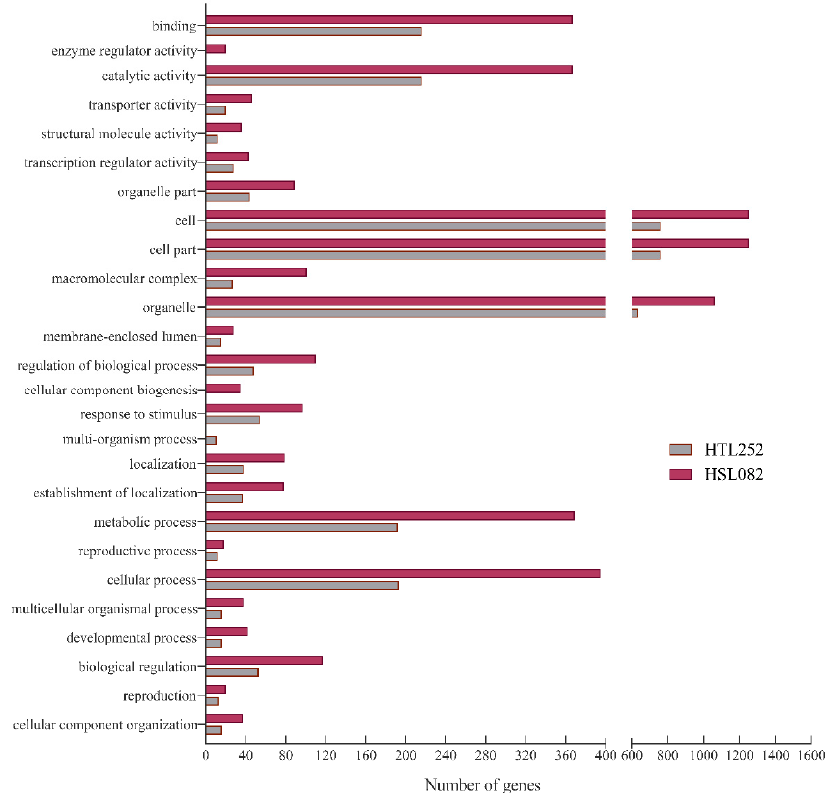
Figure 2. Gene Ontology (GO) classification of 1168 DGEs in HTL252 and 1833 DEGs in HSL082 after 5 days of HS treatment. Y -axis shows the GO terms. X -axis shows the number of genes enriched to this term.